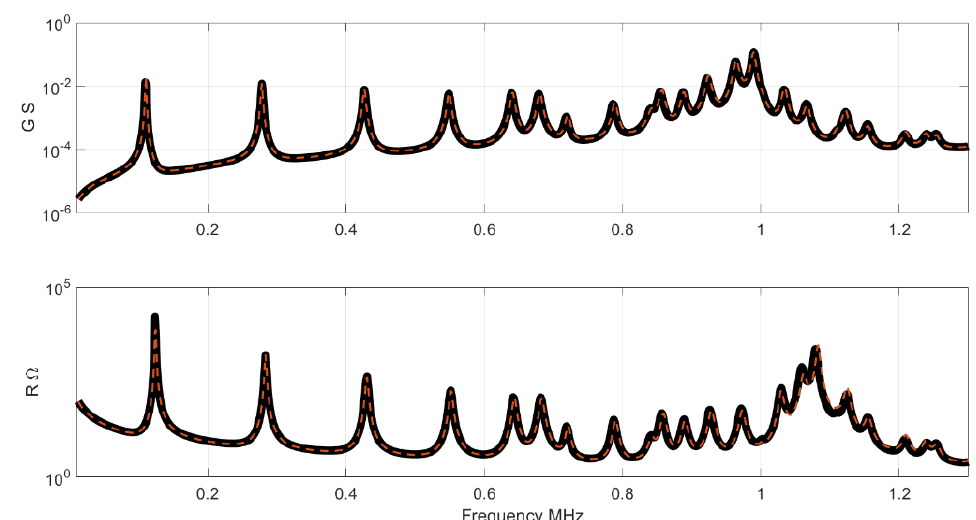
Figure 8. Results of conductance and resistance for the full set. The black curve is the impedance of the Test set, the red curve is the NN result.